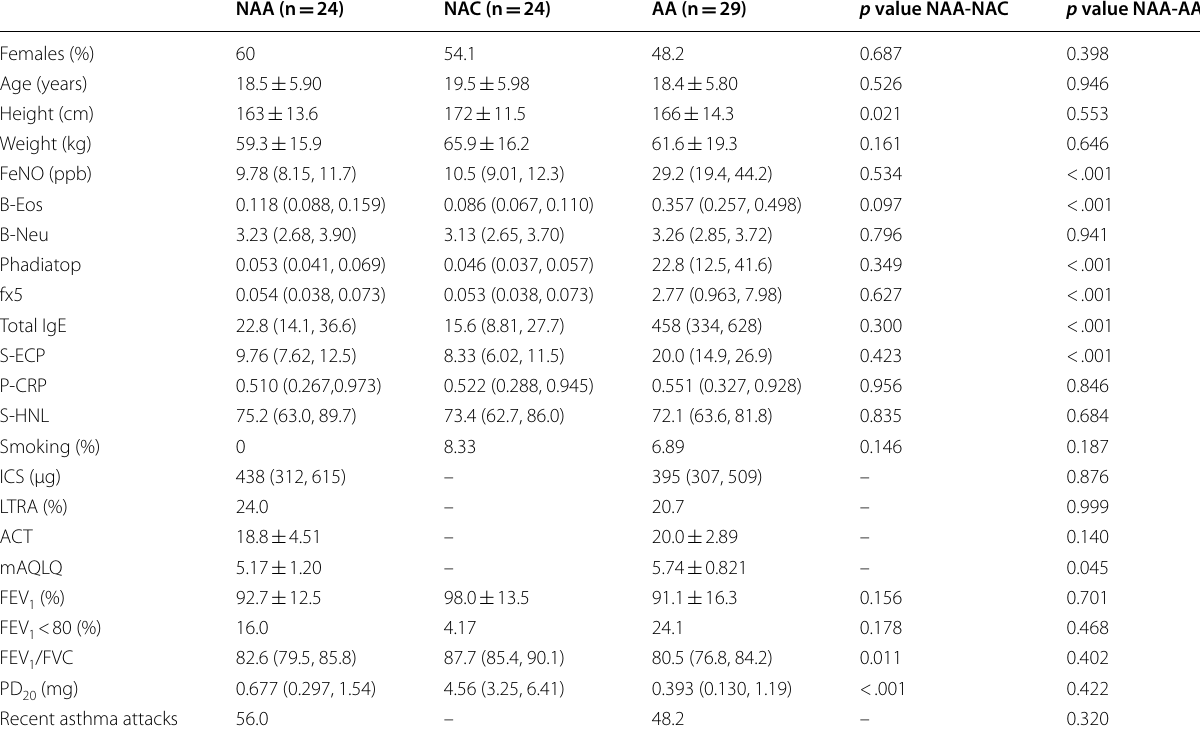
Mean SD, Geometric mean (95% CI). IgE concentrations in kU A /L, white blood cells in ±